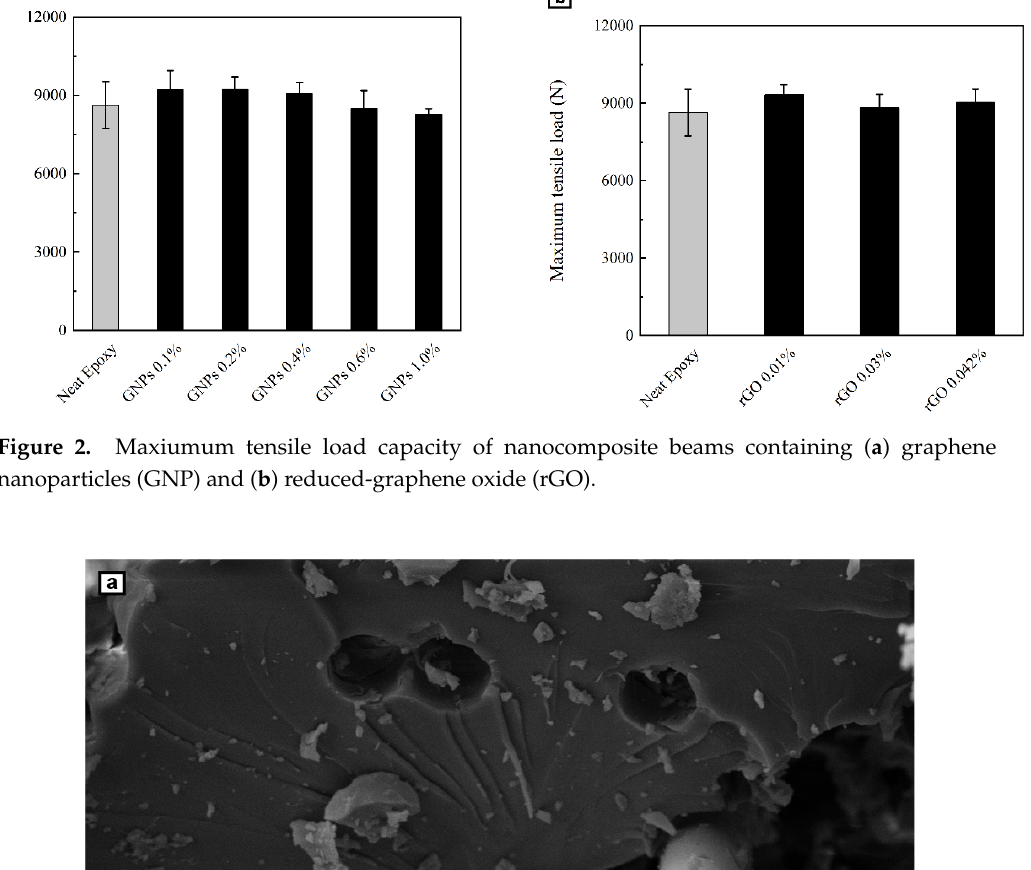
5 of 10 Figure 1. TEM graphs of nanoparticles: ( a , b ) GNPs and ( c , d ) rGO. Tensile test was used to evaluate the mechanical properties of graphene-reinforced glass